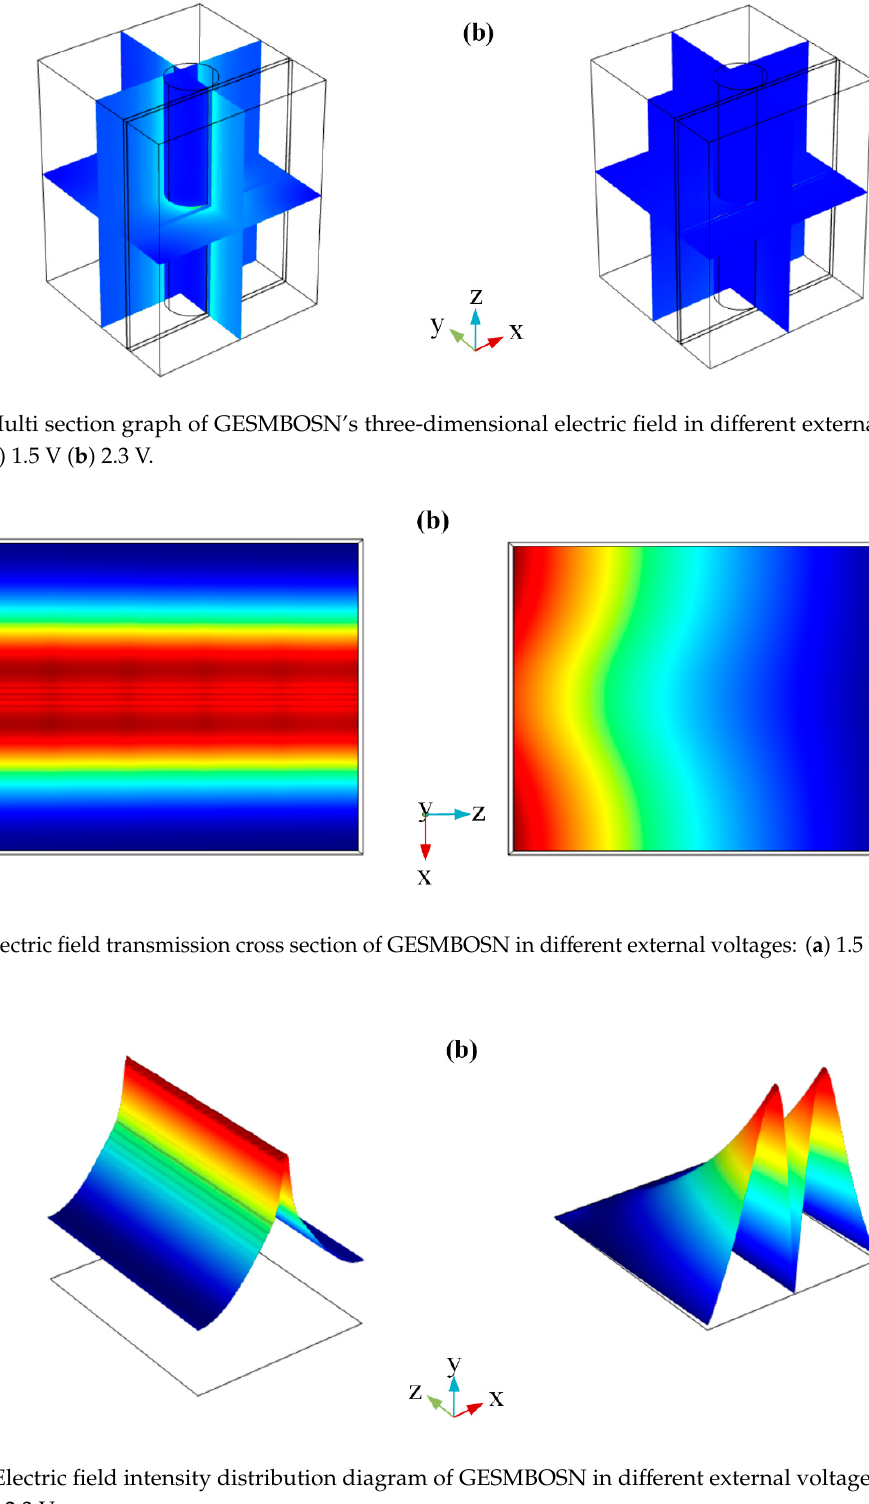
Figure 10. Electric field intensity distribution diagram of GESMBOSN in different external voltages: ( a ) 1.5 V ( b ) 2.3 V.